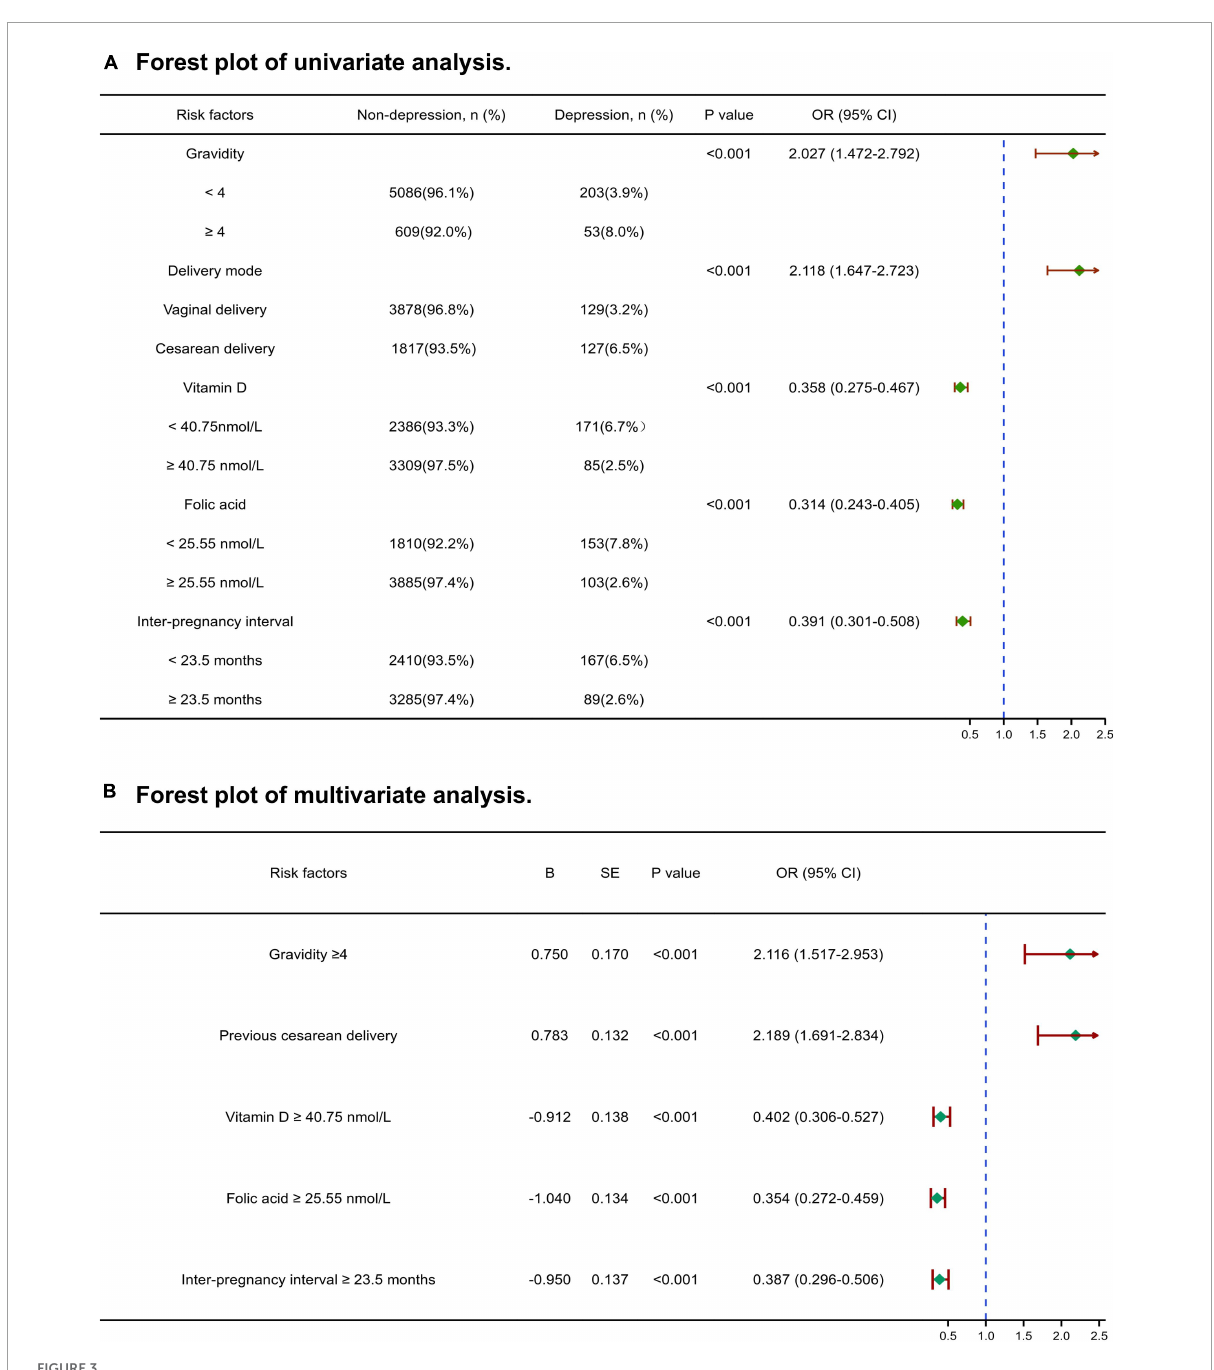
FIGURE3 Forest plot of univariate and multivariate analysis for risk factors associated with third-trimester depression. (A) Univariate analysis, (B) multivariate analysis. OR, odds ratio; CI, confidence interval. A chi-square test and logistic regression analysis were used to identify the risk factors associated with depression during